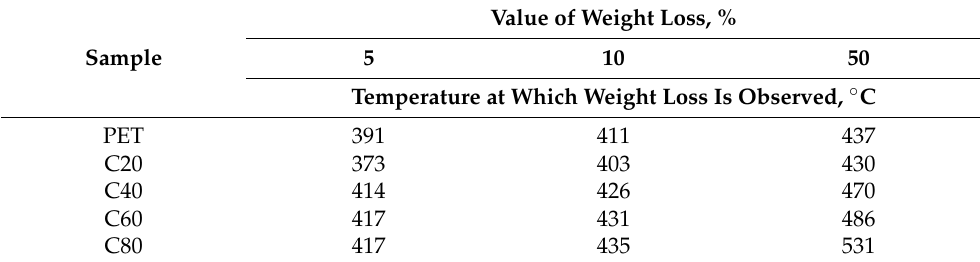
Table 5. Characteristic temperatures of weight loss for PET and C20–C80 copolyesters during heating in air at a rate of 10